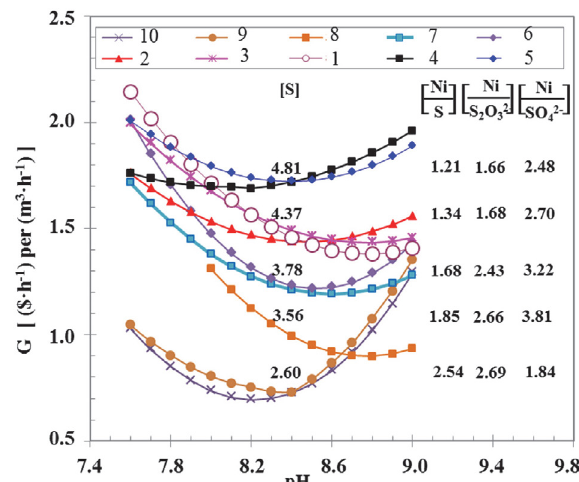
Figure 10 . Operating expenses in pH function (1.60≤NH 3 / CO 2 <1.80). The [S] average concentration (g∙L –1 ), [Ni/S], [Ni/